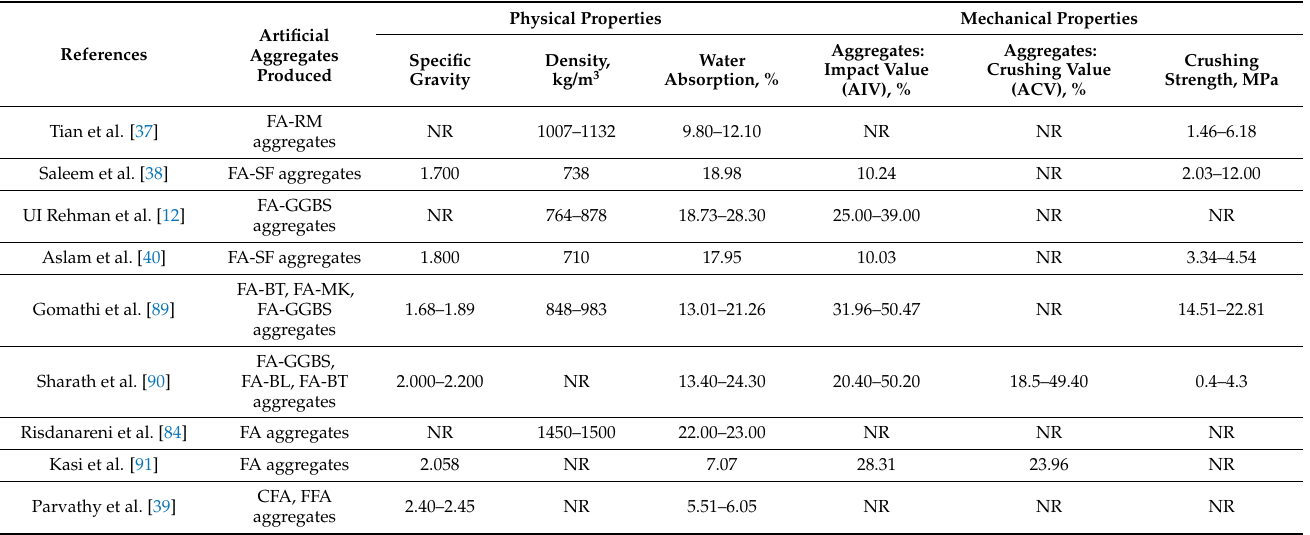
Table 4. Reported research on the physical and mechanical properties of artificial aggregates with the inclusion of